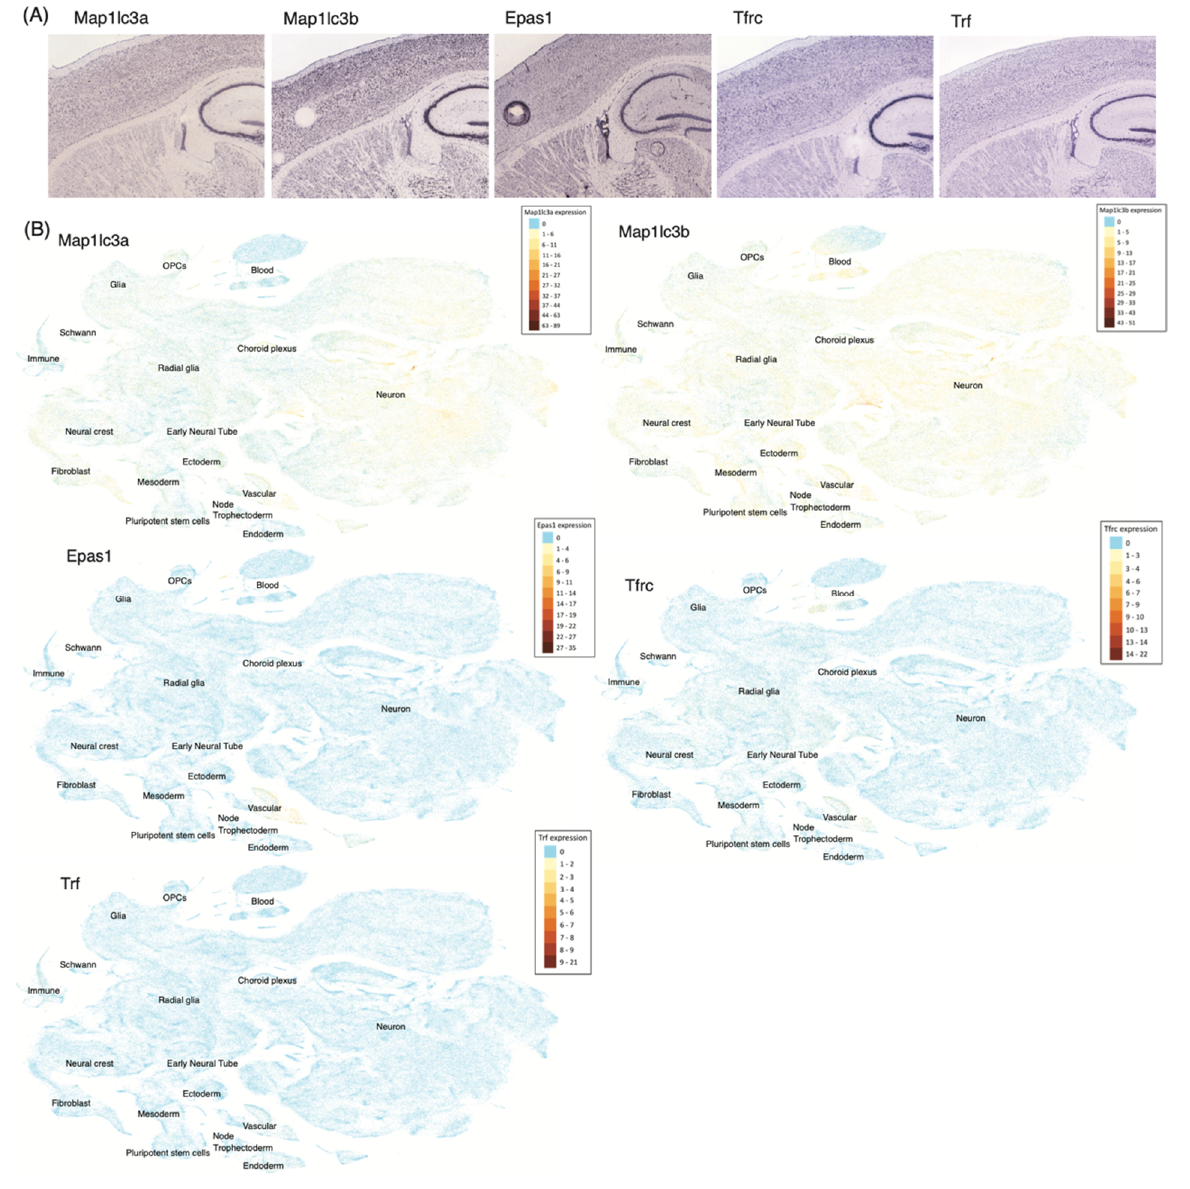
Figure 4. Ferroptosis gene expressions in the mouse brain. ( A ) Results of in situ hybridization (ISH) experiments localizing FR gene expressions in the cortices of the P56 mouse brain of Allen Brain ISH Atlas [137]. ( B ) t-SNE plot of cells expressing FR genes across the developing mouse brain, using the UCSC Cell Browser and the single cell RNA-sequencing data of Manno et al. [138]. Cell types are annotated inside the plots.